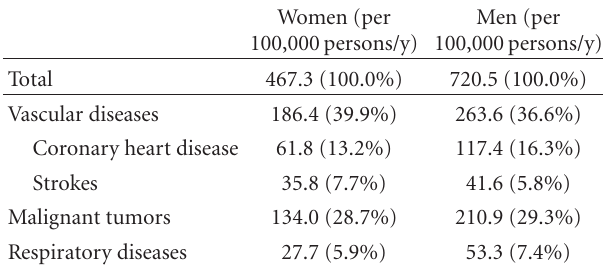
Table 1: Number of deaths (percentage of total number of deaths) for the three most frequent causes of death for women and men in Germany in 2008